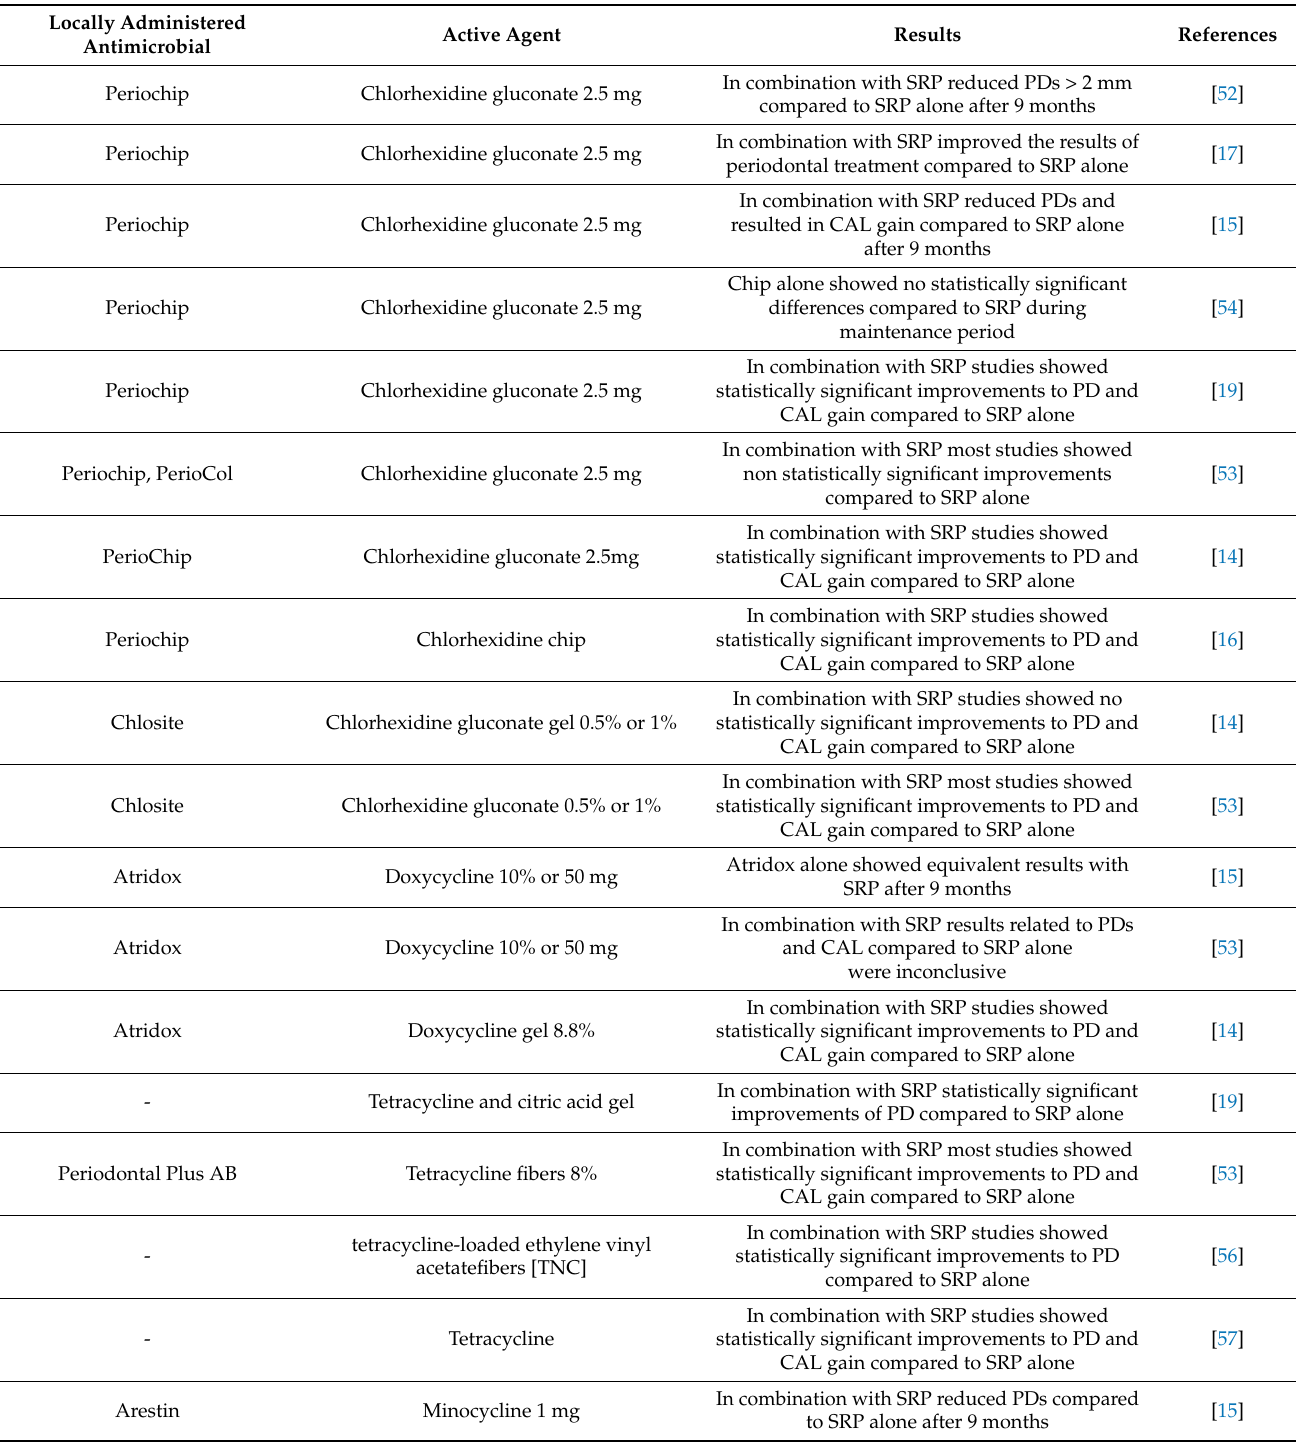
Table 1. Molecules used in local delivery as adjunctive treatment of